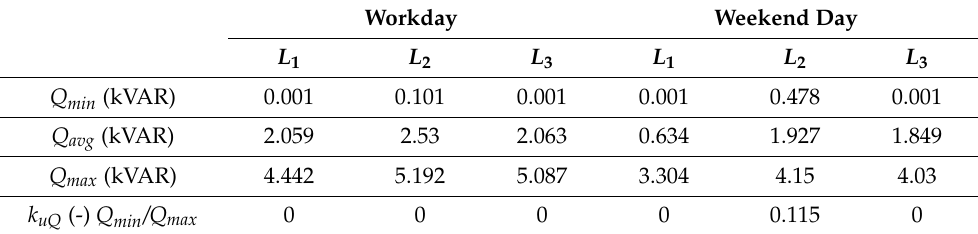
Table 2. The main values of reactive powers (absolute